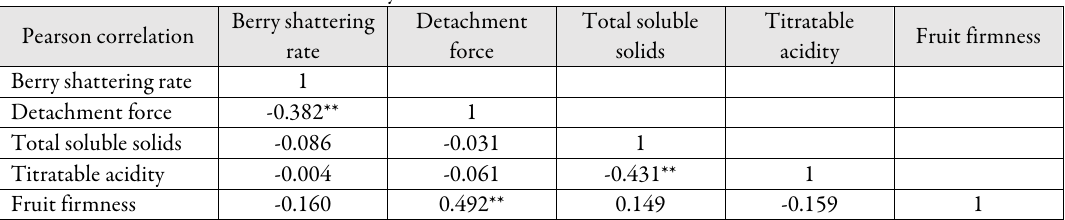
Fruit firmness -0.160